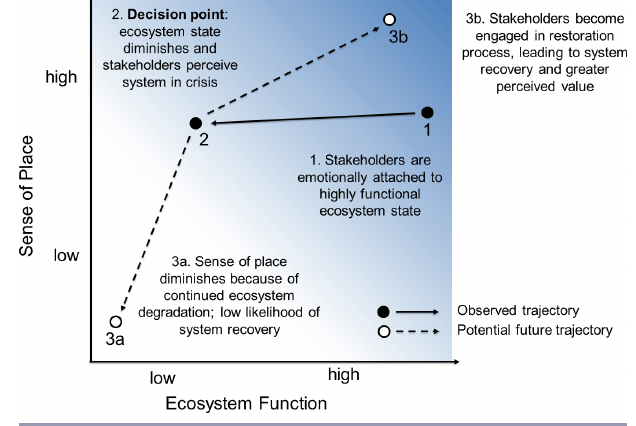
Fig. 4 . Potential trajectories of ecosystem degradation and restoration in coupled human-natural